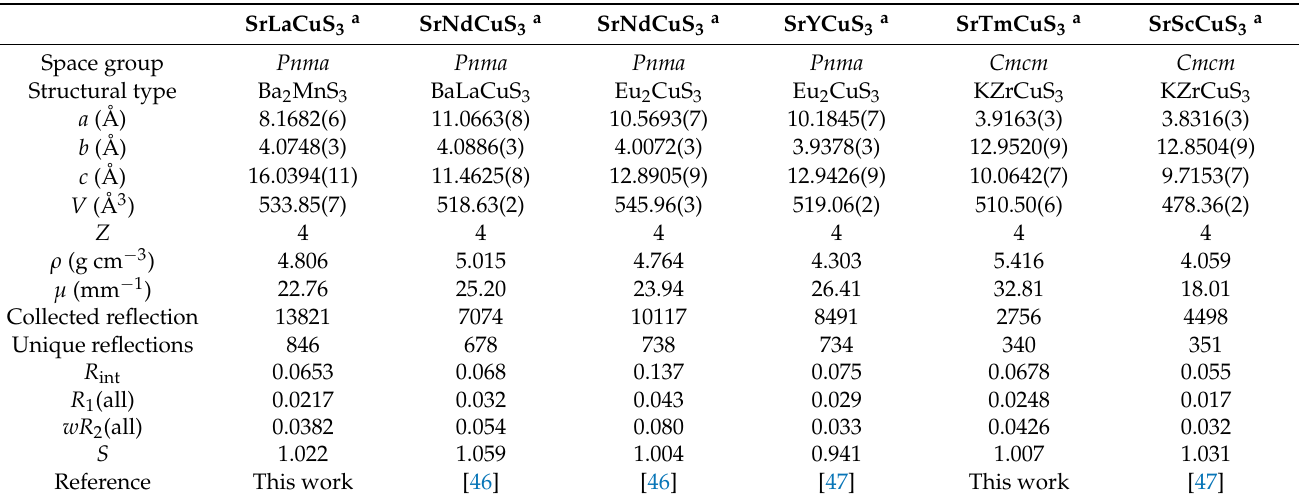
Table 1. Experimental details for the structures of SrLnCuS 3 , solved from the single-crystal X-ray diffraction